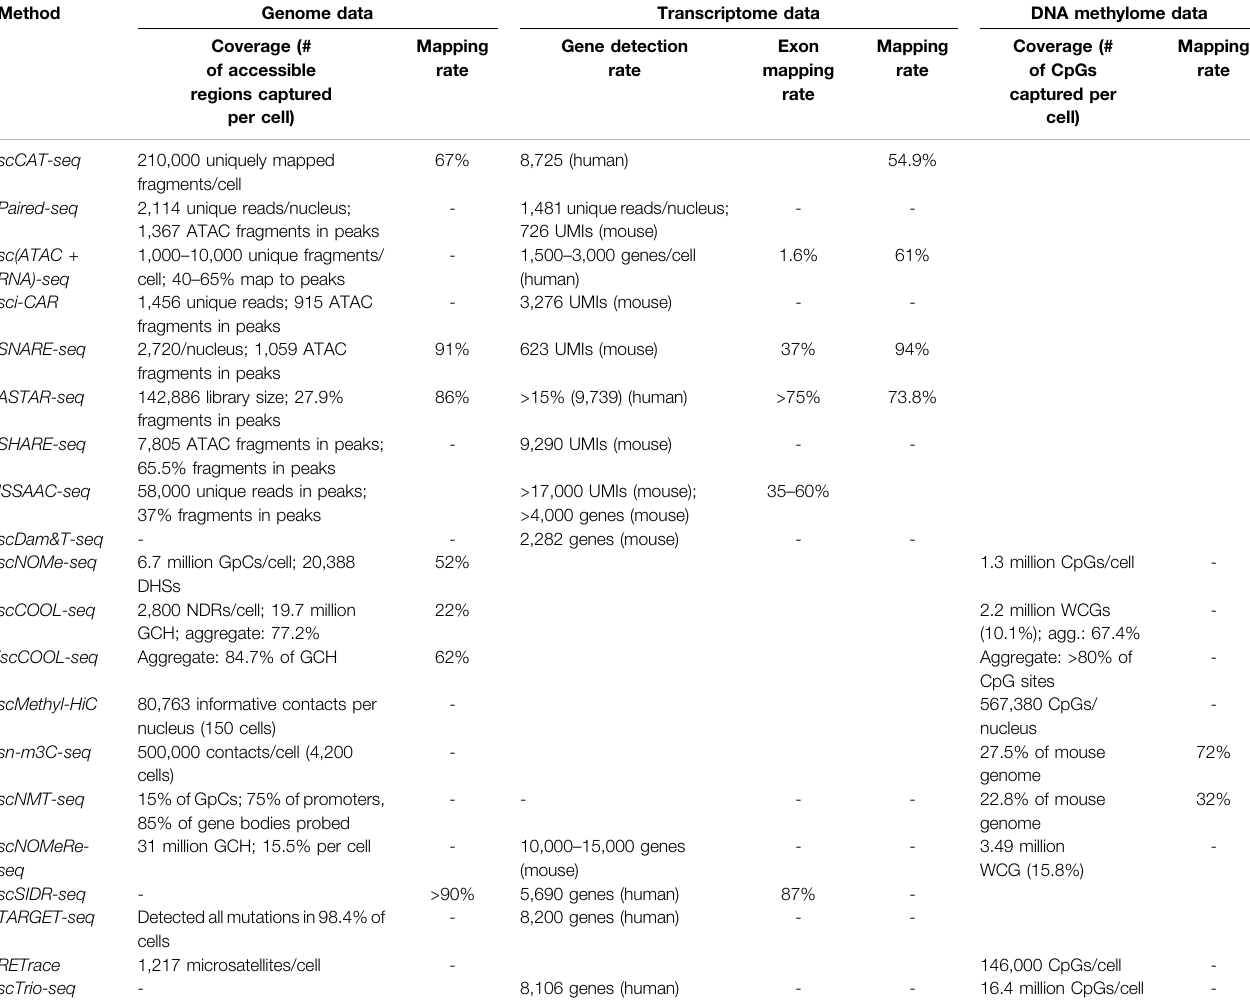
TABLE 2 | Performance in data quality and coverage achieved by the single-cell multiomics techniques